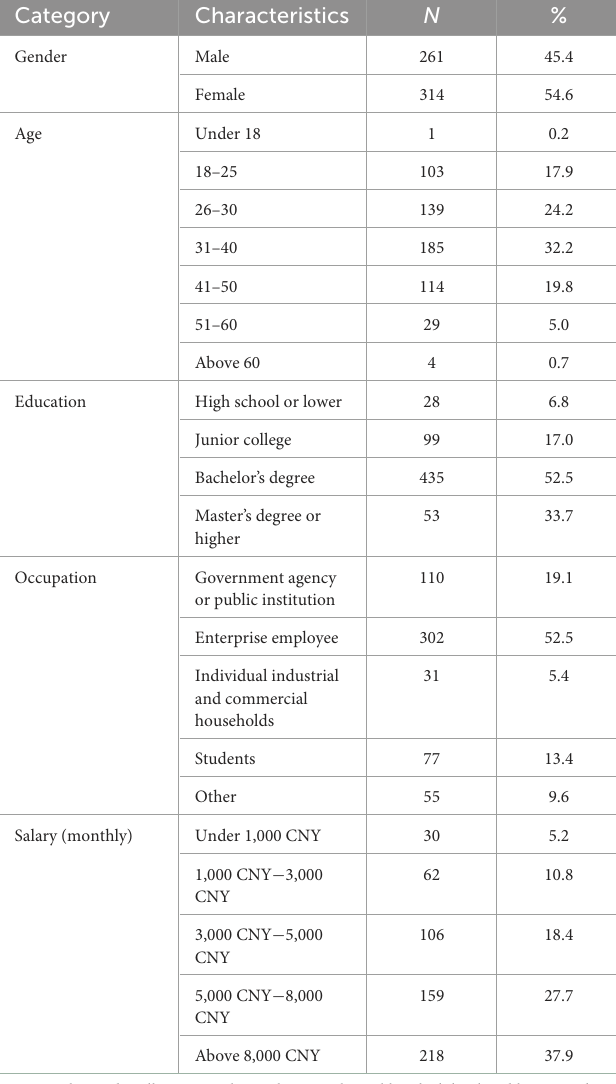
TABLE 1 Psychometric properties of the